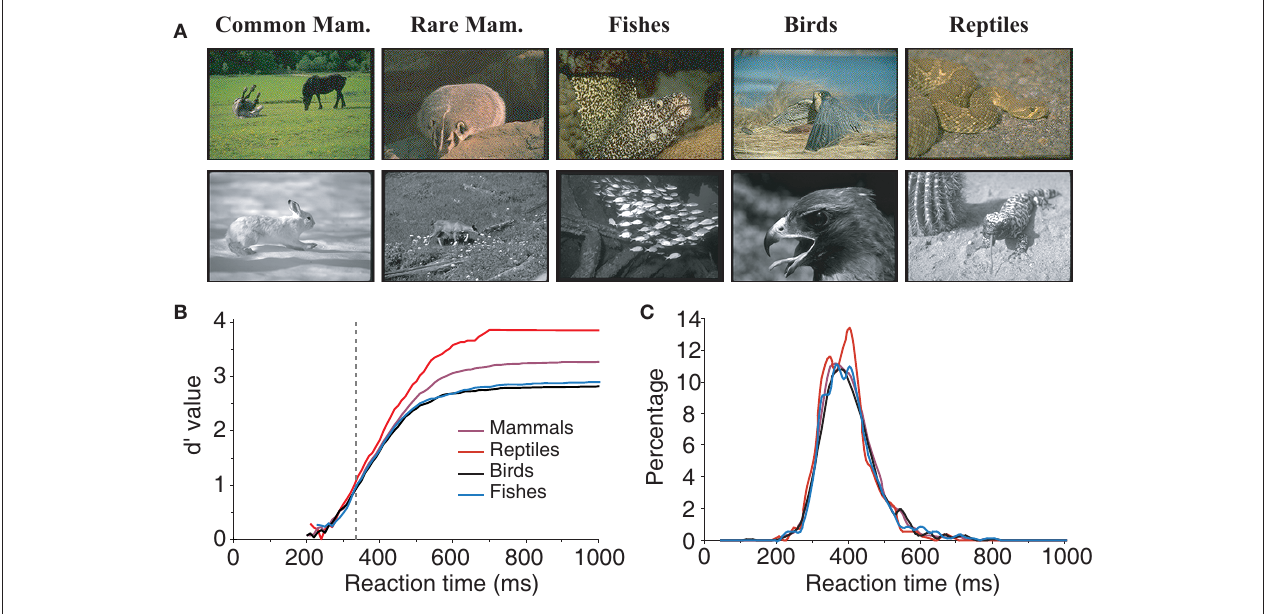
Figure 7 | influences of animal specie on subject performance. (A) Various classes of animals: mammals, fish, birds and reptiles are represented for color and BW images. Mammals were first sub-divided into two groups, common mammals (Common Mam.) and rare mammals (Rare Mam.), but no significant difference could be shown (see text) so they were grouped together for later